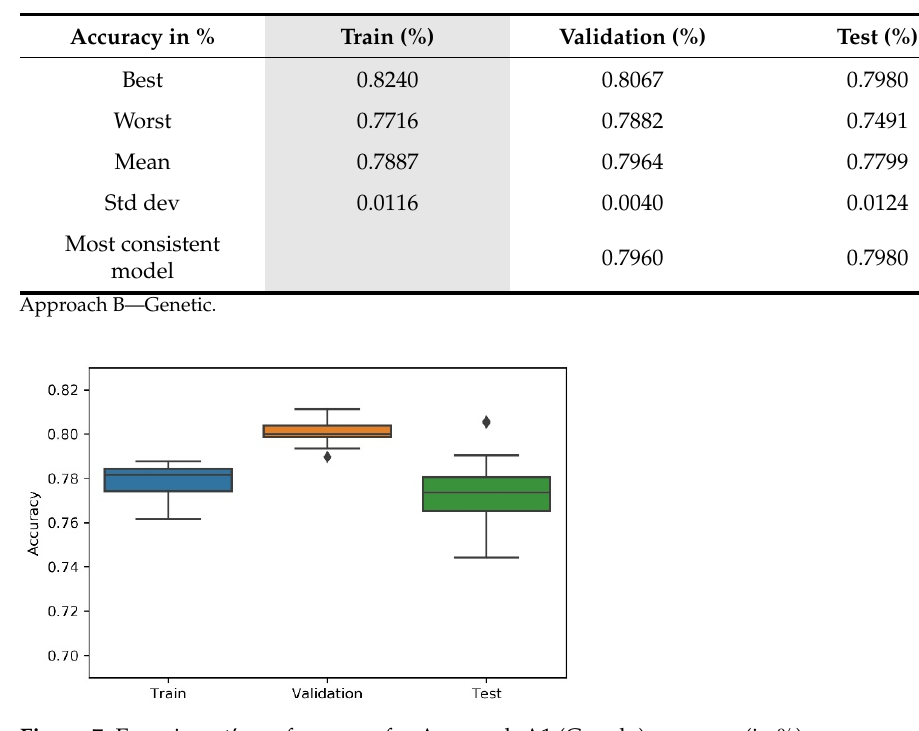
Table 5. Summary table for Approach B—Genetic accuracy (in %).